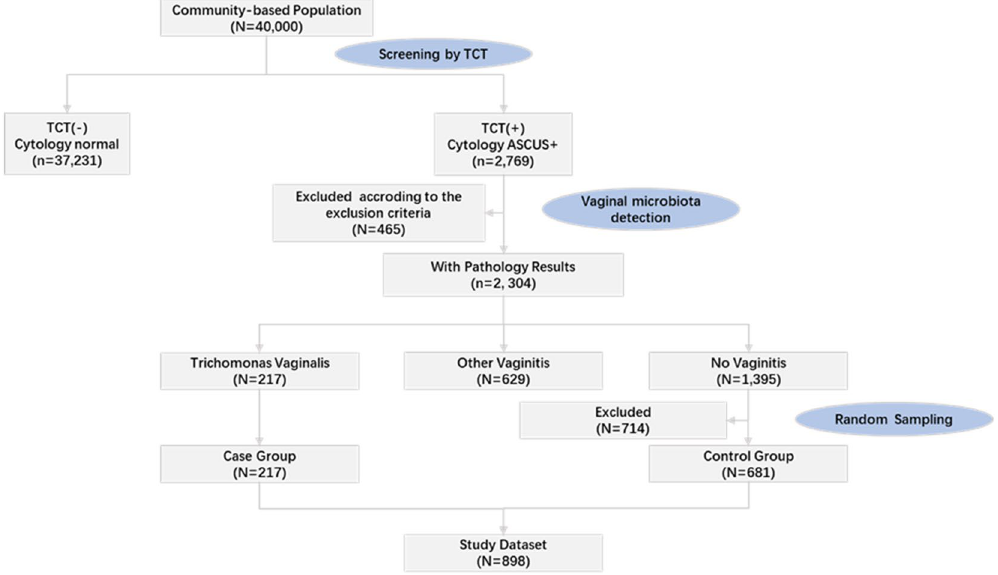
Figure 5. Flowchart of the study participants. TCT: thinprep cytologic test; ASCUS +: atypical squamous cells of undetermined significance or worse.